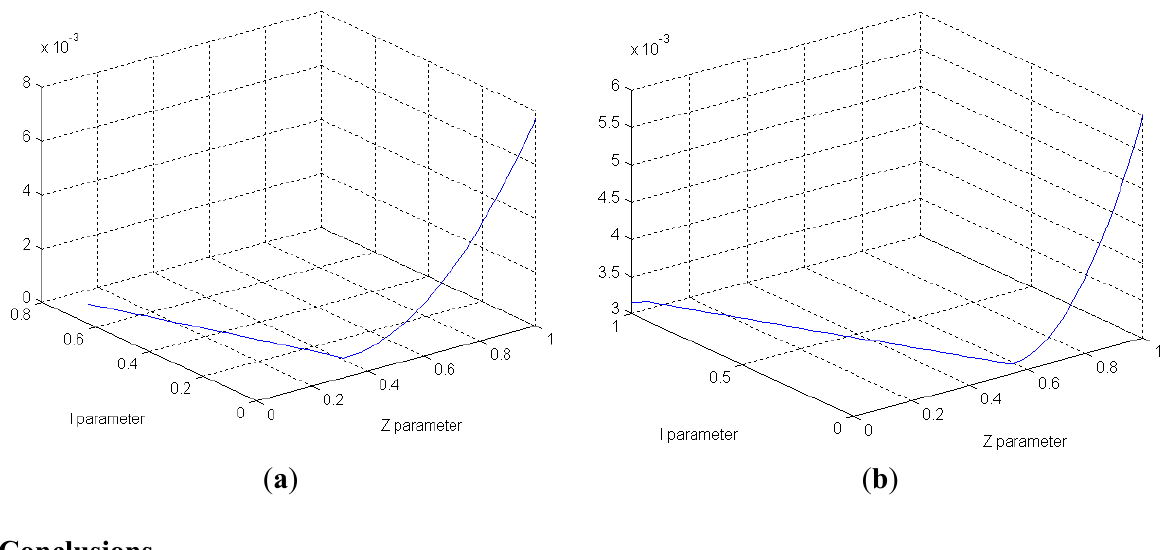
; ( b ) minimum reactive objective Z Z